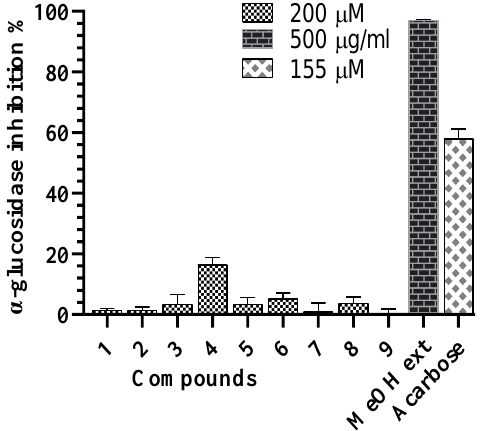
Figure 3. α -Glucosidase inhibitory effects of the G. sylvestre extract and compounds 1 – 9 .